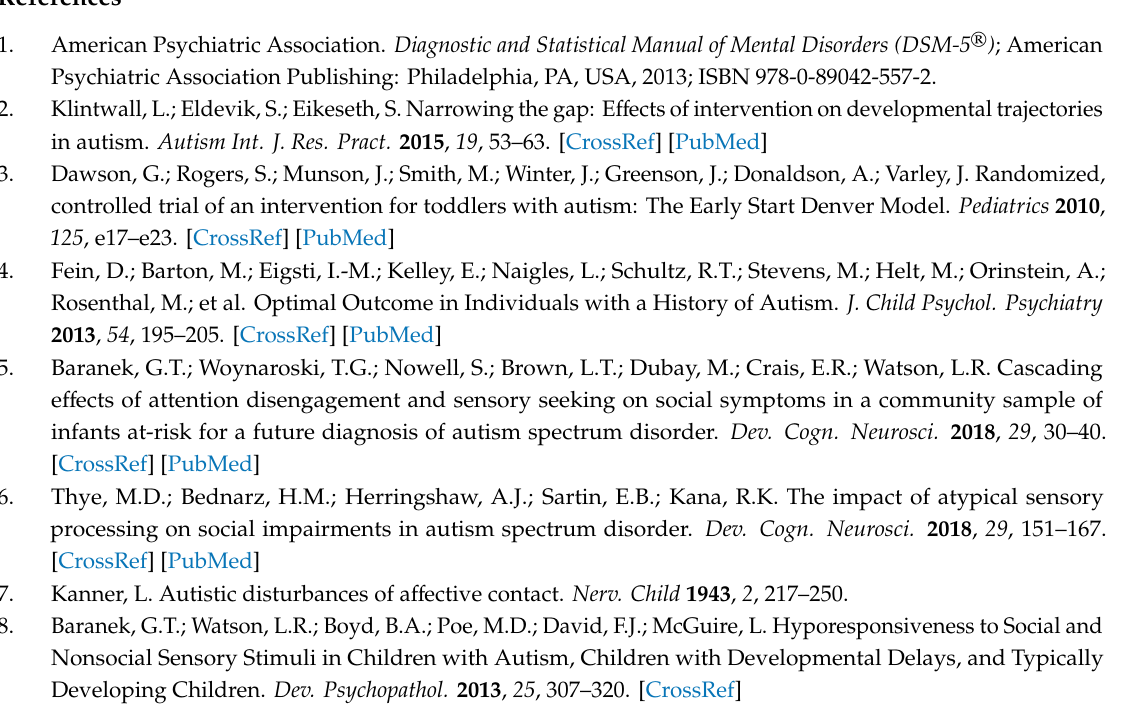
Table S1: Correlations between SRS-2 domains and sections of the SSP in children with ASD (n = 64), Table S2: Correlations between VABS-II domains and sections of the SSP in children with ASD (n = 64), Figure S1: Correlations between Sensory issues (SSP Total score) in the ASD group and gaze data in all three Social scenes: (A) Mean Fixations Duration, (B) Number of fixations, (C) Number of Saccades, (D) First Fixation duration, and (E) First Saccade amplitude, Figure S2: (A.1–2) Correlations between Sensory issues (SSP Total score), and Proximity to TD gaze pattern (Proximity mean) with the percentage of Fixations duration greater than 1000ms in the ASD group; (B.1–2) Sensory processing (SSP Total score), and Proximity to TD gaze pattern (Proximity mean) comparisons between children with ASD who had fixations greater than 1000ms (Longer fixations) and fixations lesser than 1000ms (Shorter fixations); (C) Percentage of fixations greater than 1000ms comparison between ASD and TD groups. Figure S3: (A.1–2) Correlations between Sensory issues (SSP Total score), and Proximity to TD gaze pattern (Proximity mean) with the percentage of Fixations duration greater than 1000ms in the ASD group; (B.1–2) Sensory processing (SSP Total score), and Proximity to TD gaze pattern (Proximity mean) comparisons between children with ASD who had fixations greater than 1000ms (Longer fixations) and fixations lesser than 1000ms (Shorter fixations); (C) Percentage of fixations greater than 1000ms comparison between ASD and TD groups. Figure S4. Correlations between Sensory issues (SSP Total score) and Social responsiveness scale (SRS-2) in a group of typically developing